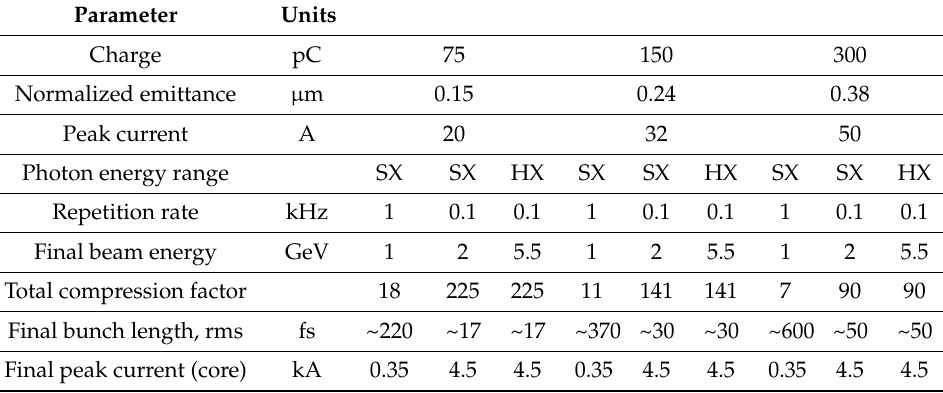
Table 3. CompactLight electron beam parameters at the injector exit (~100 MeV) at the nominal bunch charge of 75 pC (from simulations) and at higher charges (from scaling with Equations (4) and (5). Final beam energy, duration, compression factor, and final peak current are reported for the 3 scenarios in Figure